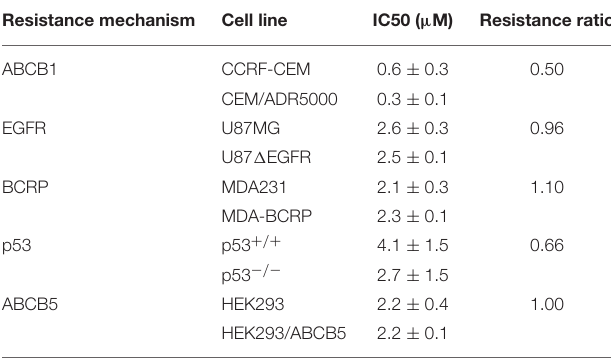
TABLE 2 | IC 50 values of different drug-sensitive and -resistant cell lines of Sanguinarine. Resistance